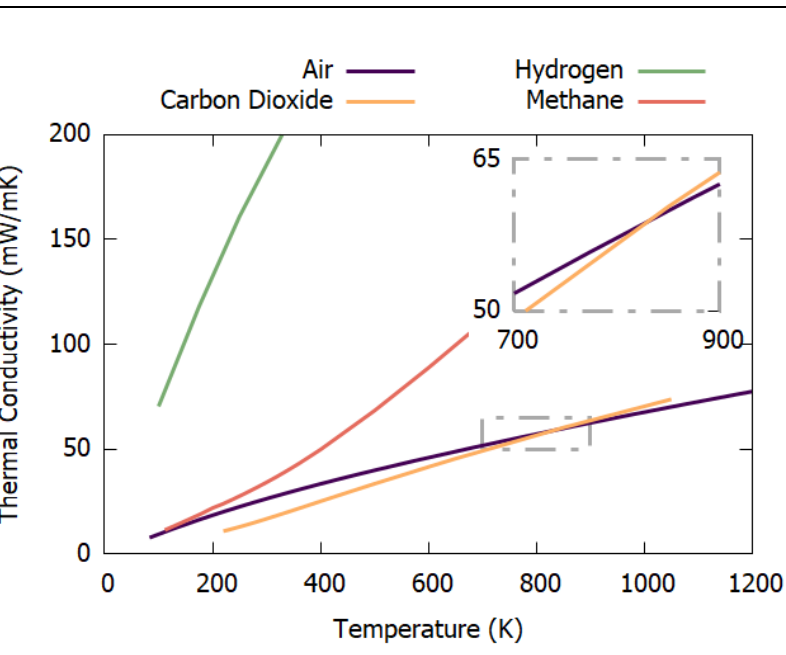
Figure 3. A plot showing how the thermal conductivity of air, carbon dioxide, hydrogen and methane vary with temperature. Inset—detailed view of where air and carbon dioxide intersect.